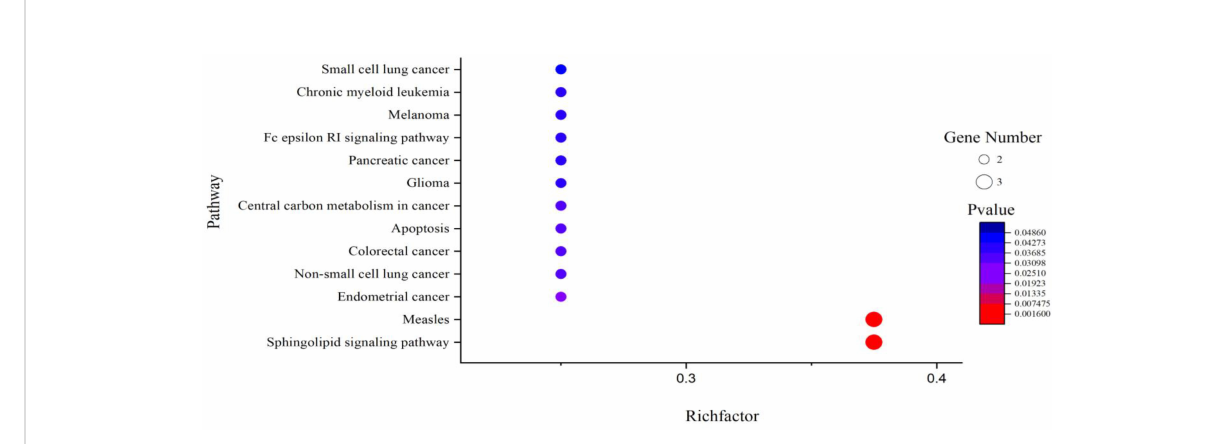
FIGURE 7 KEGG pathway analysis for the SARS-CoV-2 speci fi c targets of active components in QFPD. The rich factor indicates the ratio of the number of target genes belonging to a pathway to the total number of annotated target genes in the pathway. The higher value for this ratio corresponds to a higher level of enrichment. The size and color of the bubble indicates the number and signi fi cant characters of target genes that enriched in